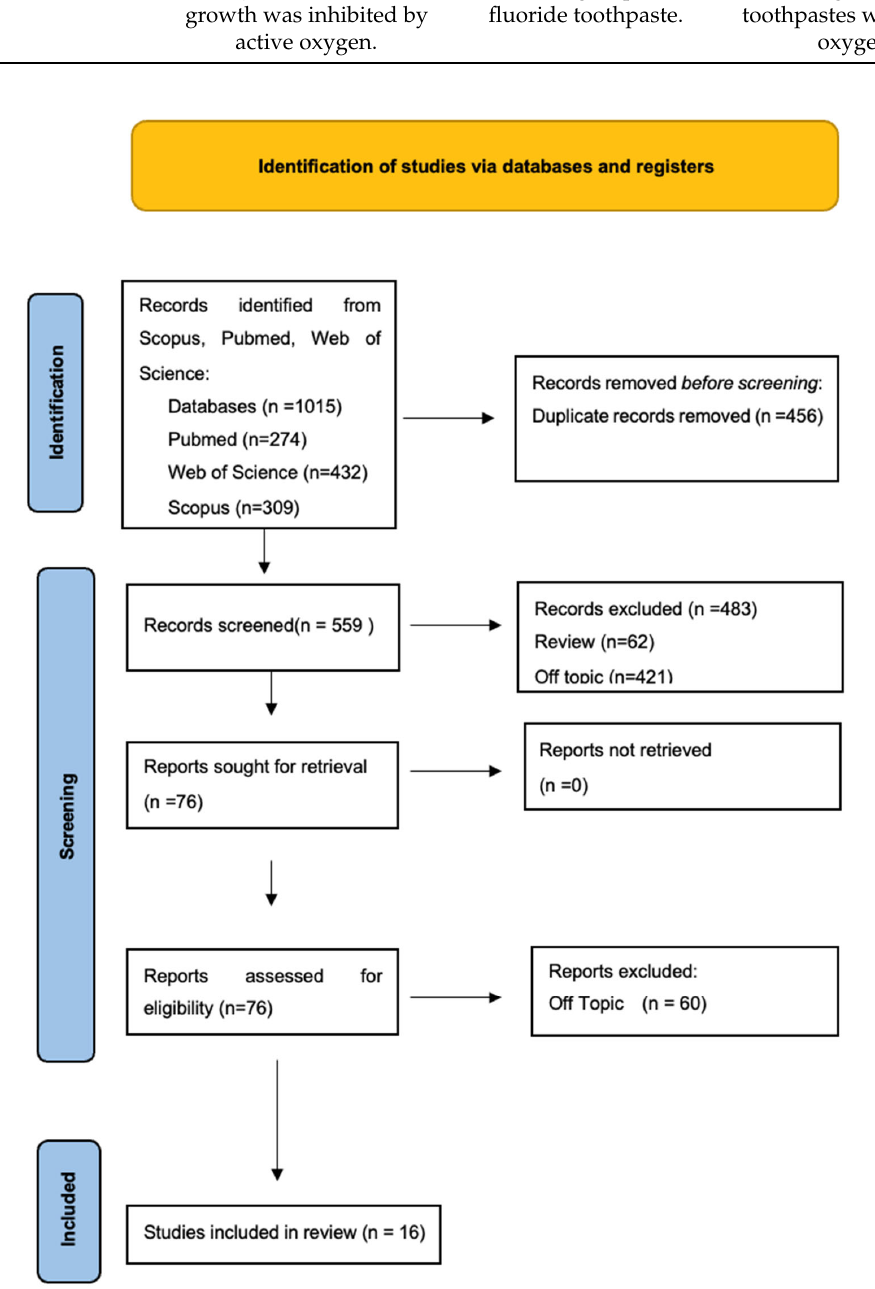
Figure 2. PRISMA flowchart. Figure 2. PRISMA Table 2. Studies included in the systematic review.